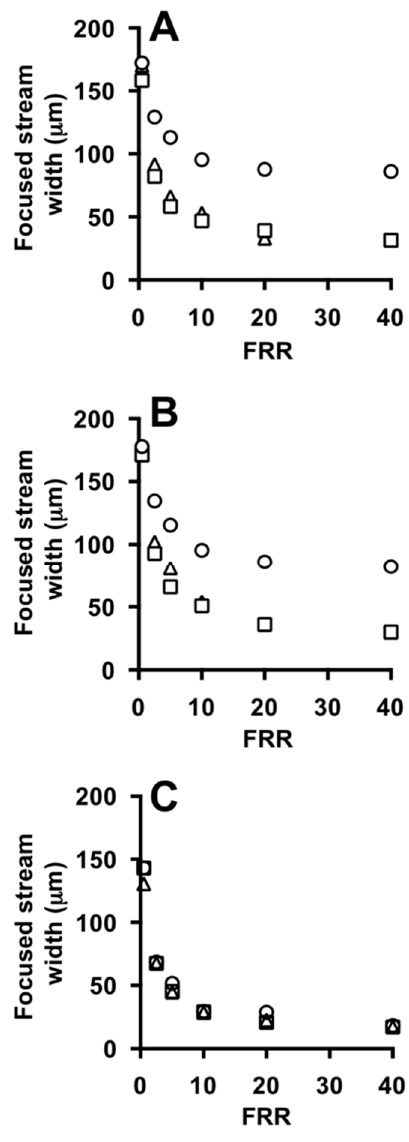
Figure 6. Effect of FFR on the focused stream width at different TFRs, measured from experiments ( A , B ) and simulations ( C ) using #chip1-MHF. TFR was set to 18.75 (circles), 37.50 (squares) and 75.00 (triangles) µL/min. Experiments were carried out in the absence ( A ) or in the presence of liposome forming lipids ( B ). Data represent the average of 3 measurements ± SD (the maximum standard deviation is equal to 0.9).